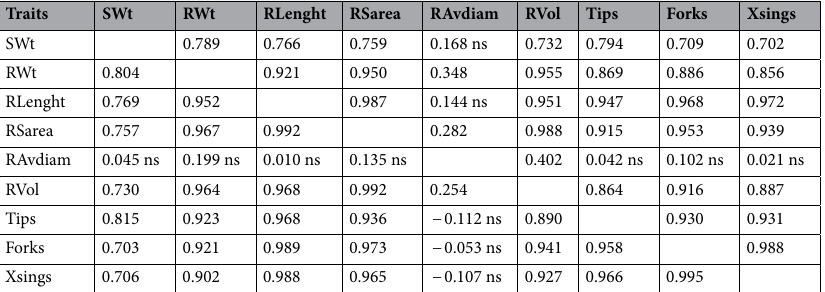
Table 2. The genetic correlations and phenotypic correlations of root traits. The table shows the genetic correlations (lower triangle) and phenotypic correlations (upper triangle) of eight root trait and one shoot trait under high N-management. SWt, shoot weight, RWt, root weight, RLength, root length, RSarea, root surface area, RAVdiam, root average diameter, RVol, root volume, Tips, number of root tips, Forks, number of forks, Xsings, number of crossings, ns, not significant at P ≤ 0.05; all others, significant at 0.05 > p <